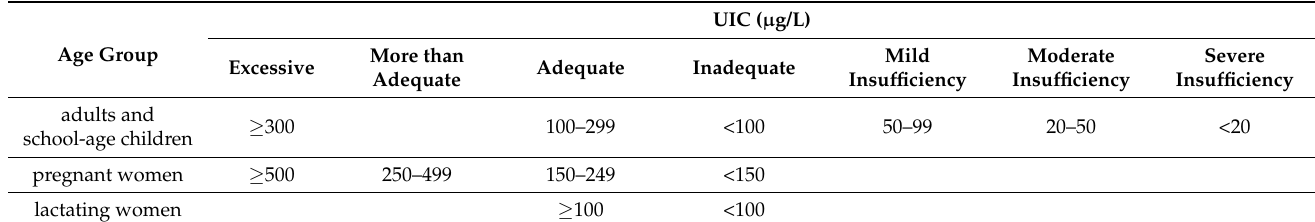
Table 1. Assessment of iodine nutrition based on urinary iodine concentrations (UIC) and grades of iodine deficiency according to World Health Organization (WHO)